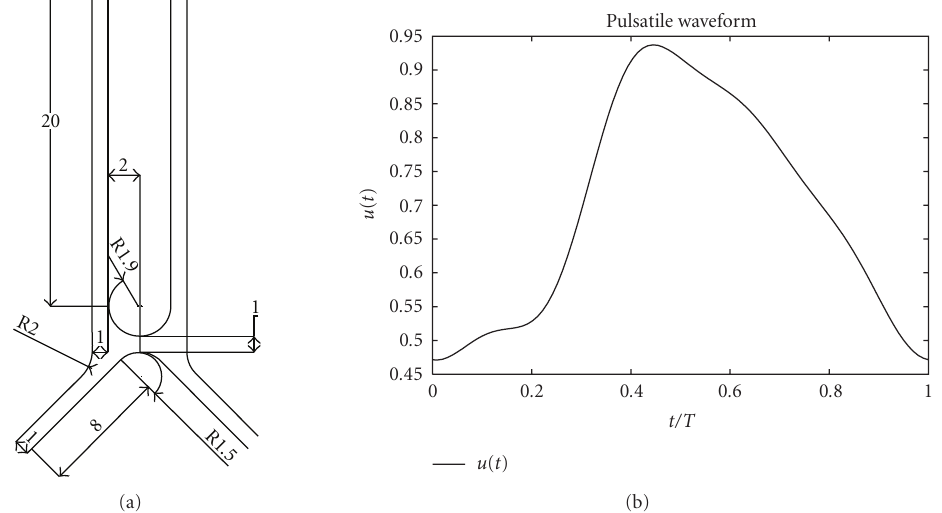
Figure 2: (a) ACA-ACOM geometry with 45 degree bifurcation angles. (b) Pulse waveform given by (3). The global maximum occurring at 0.45 t/T will define the transition between the systolic and diastolic phases of the flow waveform.